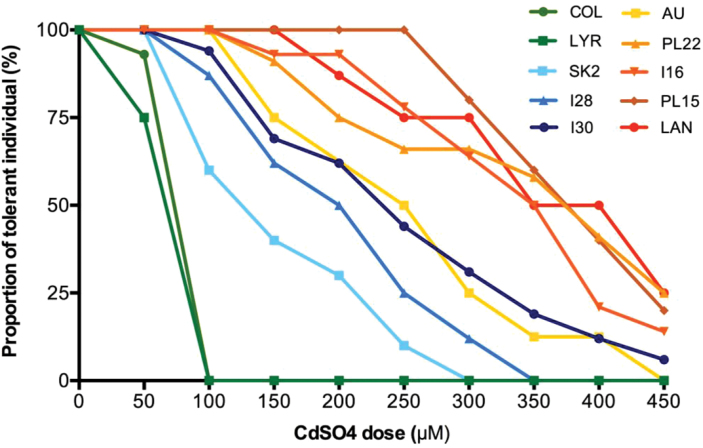
Cadmium tolerance of NM (SK2, I28, I31) and M (AU, PL22, I16, PL15, LAN) A. halleri populations and of A. thaliana (ecotype Col-0) and A. lyrata petraea (LYR). At each experimental dose, growth was encoded for each plant as a binary variable and interpreted as individual tolerance or sensitivity. n= 4–16. (This figure is available in colour at JXB online.)